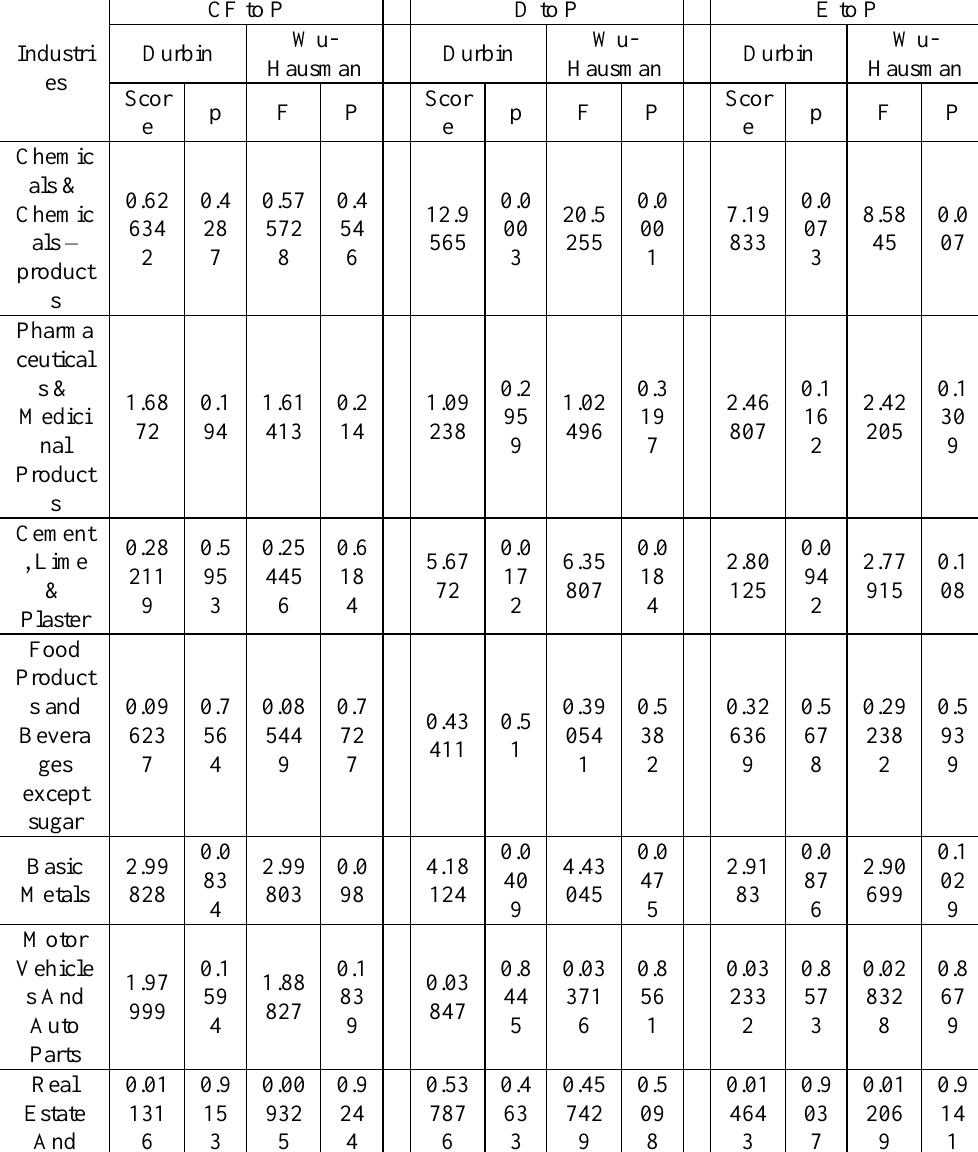
Table 5. Robustness Tests Detailed